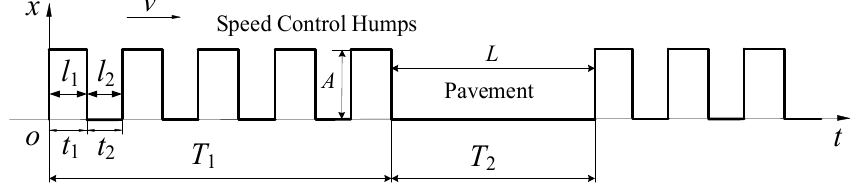
Figure 5. The consecutive speed control humps model.